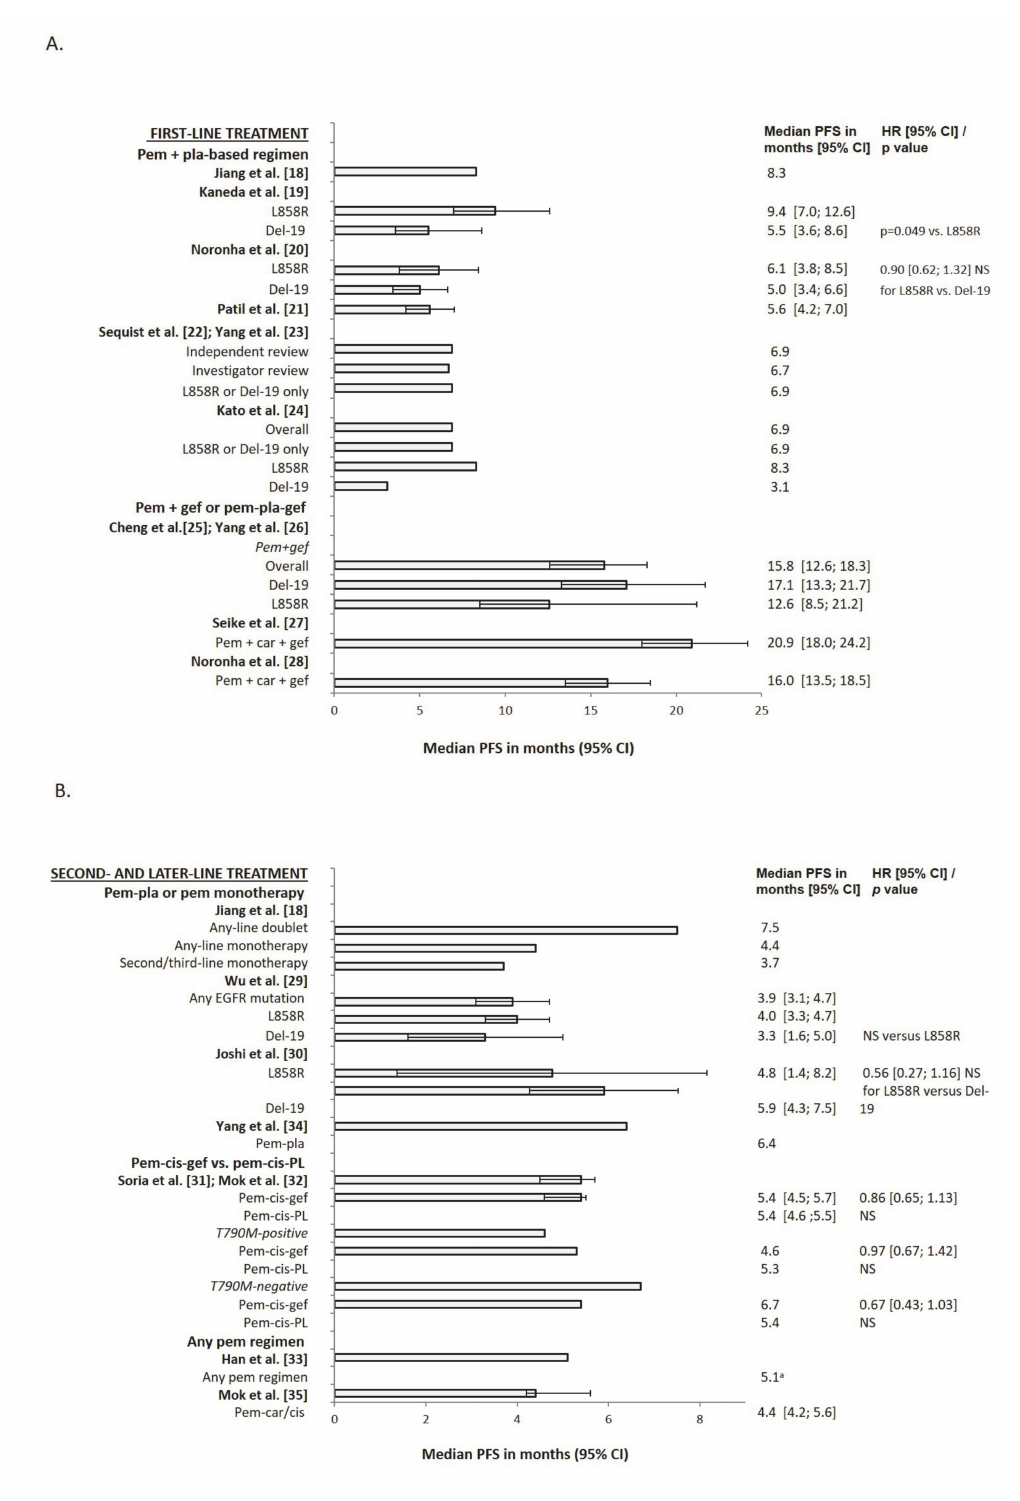
Figure 1. Median progression-free survival (PFS) with ( A ) first-line and ( B ) second- and later-line pemetrexed-basedtreatmentinpatientswithadvancednonsquamousNSCLCandEGFRgenemutations. a Weighted median PFS. Abbreviations: carboplatin (car); cisplatin (cis); confidence interval (CI); EGFR gene exon 19 deletion (Del-19); epidermal growth factor receptor (EGFR); gefitinib (gef); hazard ratio (HR); Leu858Arg point mutation in exon 21 (L858R); not significant (NS); non-small-cell lung cancer (NSCLC); pemetrexed (pem); progression-free survival (PFS); placebo (PL); platinum